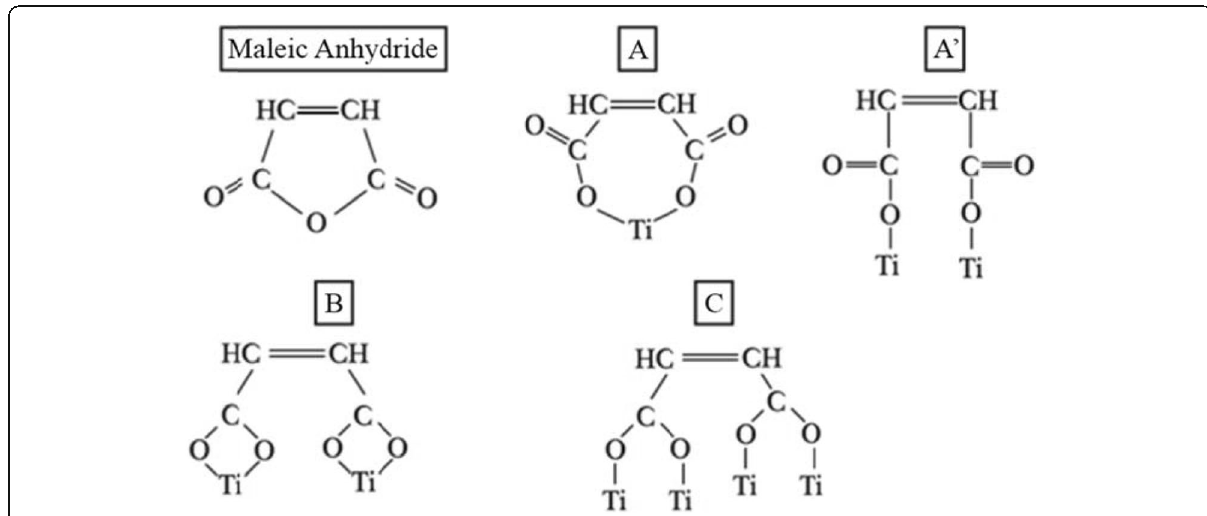
Fig. 6 Possible adsorption modes of the MA molecule on the TiO 2 surface: A and A ’ ) monodentate, B) bidentate chelating, and C) bidentate